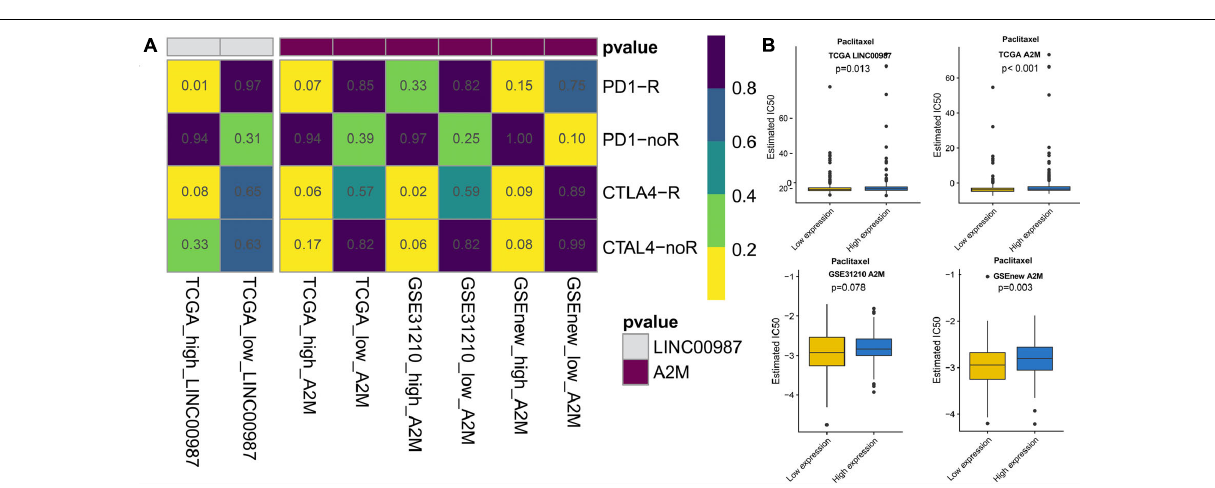
FIGURE 7 | Response to immunotherapy and sensitivity to chemotherapy in relation to the expression of LINC00987 and A2M in TCGA, GSE31210, and GSEnew cohorts. (A) Sensitivity response of high vs. low expression of LINC00987 to PD1 and CTLA-4 inhibitors ( p = 0.01). (B) Boxplots of the estimated IC50 for paclitaxel in high vs. low expression of